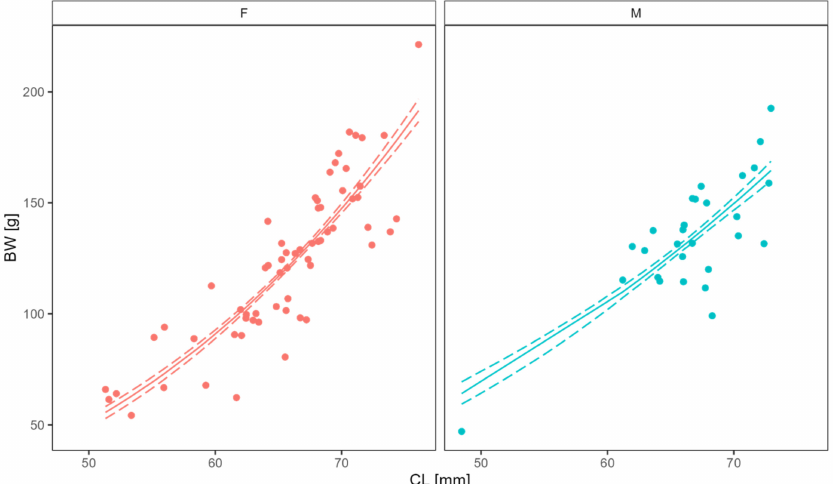
Figure 3. Length-weight relationships of Calappa granulata males (M) and females (F) collected from the central eastern Adriatic Sea (CL–carapace length, BW–body